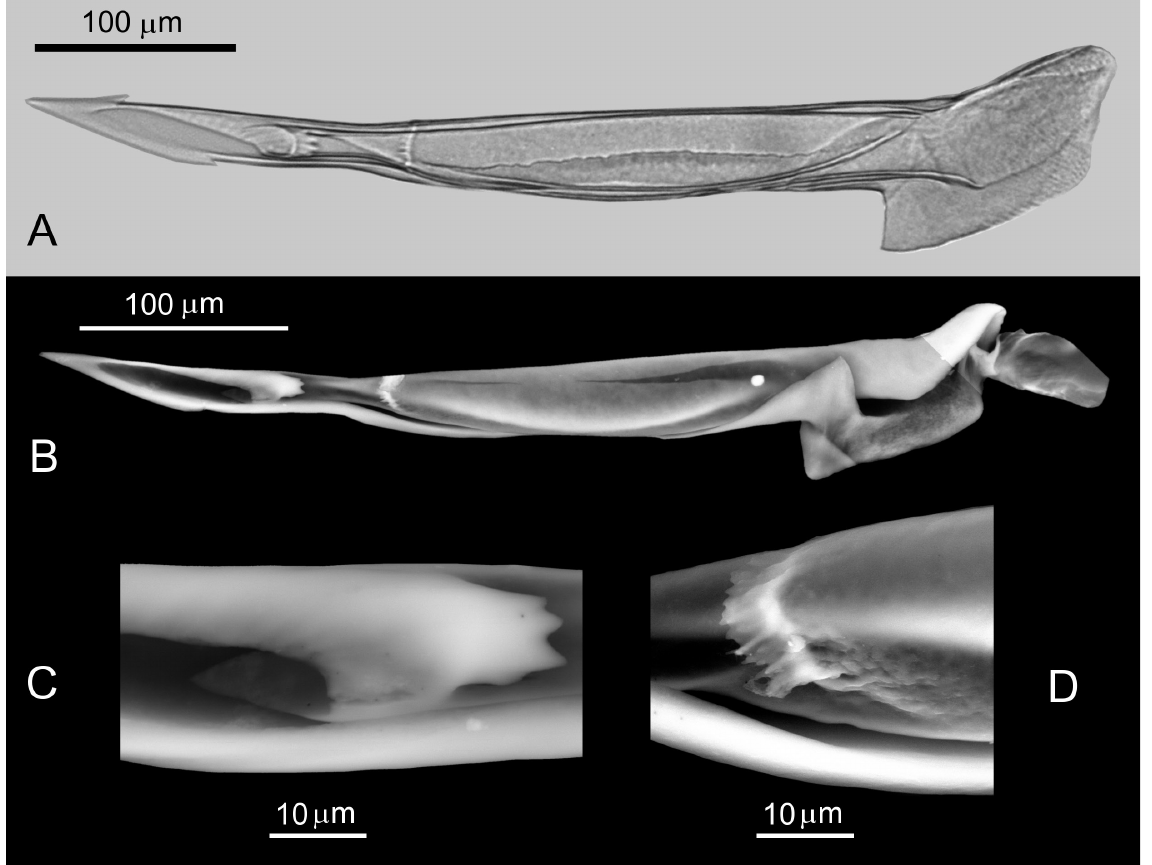
Fig. 13. Radular teeth extracted from Profundiconus puillandrei sp. nov. A . Optical photomicrograph (holotype, MNHN IM-2000-30771, S 43.2 mm). B . SEM photomicrograph (paratype 3, MNHN IM- L 2000-30774, S 35.0 mm). C . Enlargement of the external cusp. D . Enlargement of the middle section L of